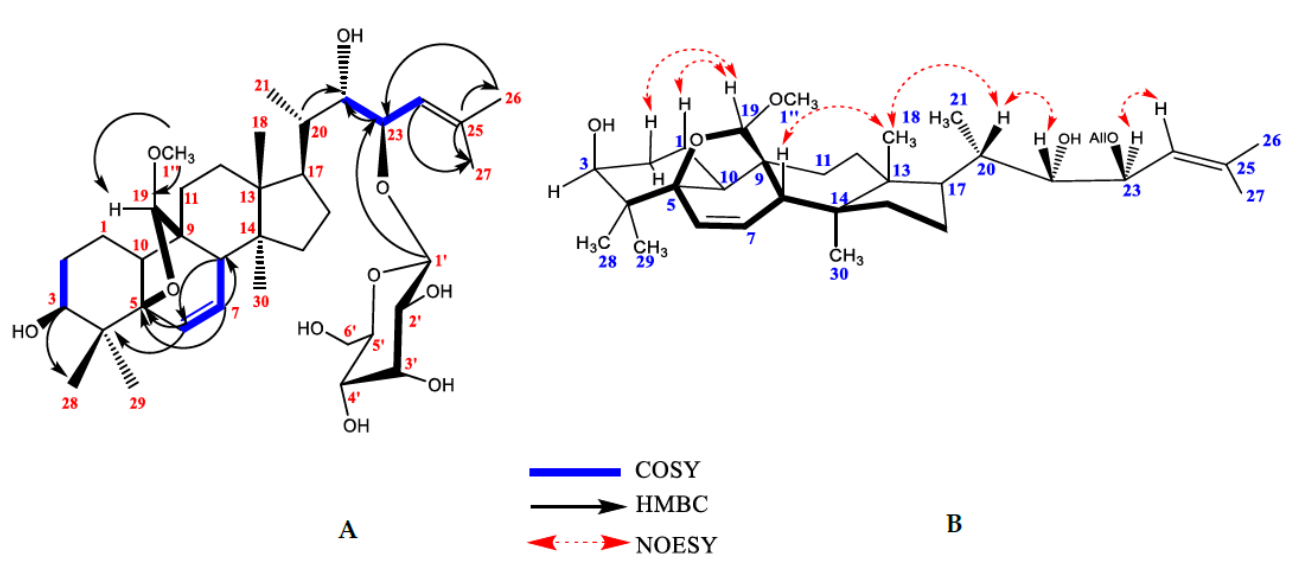
Figure 1. Crucial HMBC, 1 H- 1 H COSY ( A ) and NOESY correlations ( B ) for compound 6.